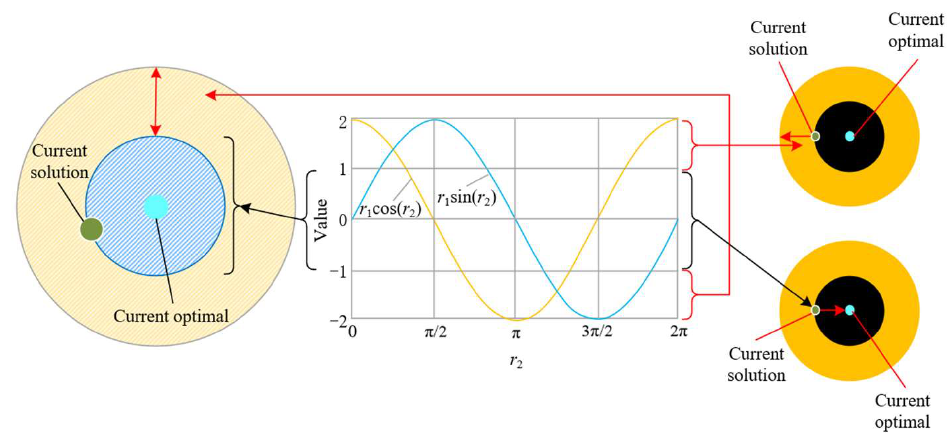
Figure 3. The iteration principle of the